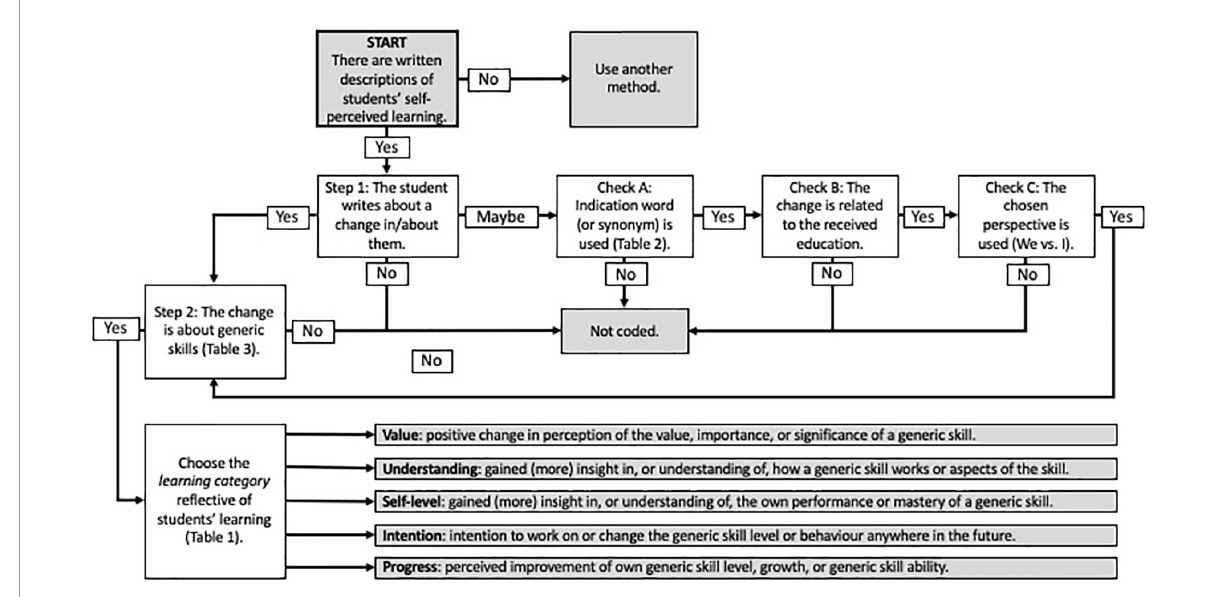
FIGURE2 Decision tree representing the students’ generic skills learning